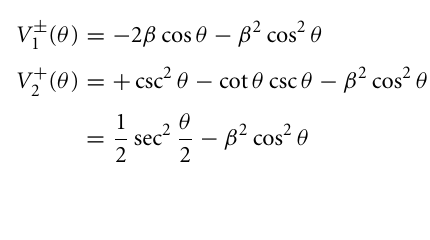
The SUSY partner potentials for cases B.1 and B.2 take the